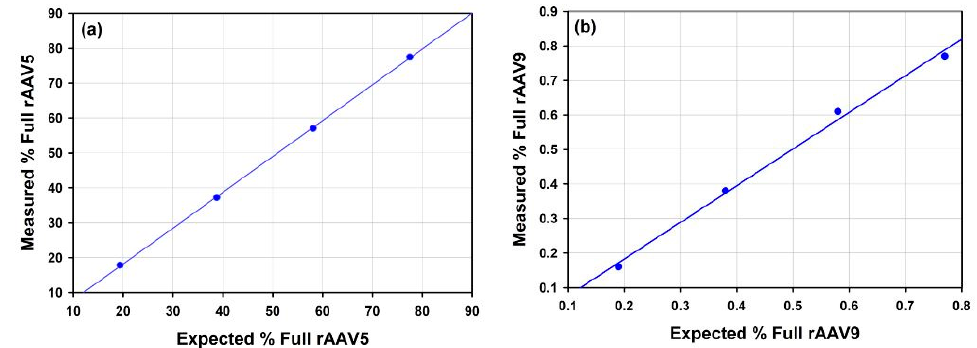
Figure 7. Charts show the measured percentage of full rAAV in comparison to the expected values based on mixing the nominally full and empty rAAV: ( a ) rAAV5, R 2 = 0.000852; ( b ) rAAV9, R 2 = 0.994974.